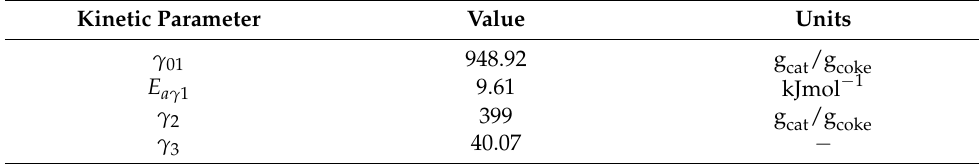
Table A3. List of parameters for the catalyst deactivation [7]. Kinetic Parameter